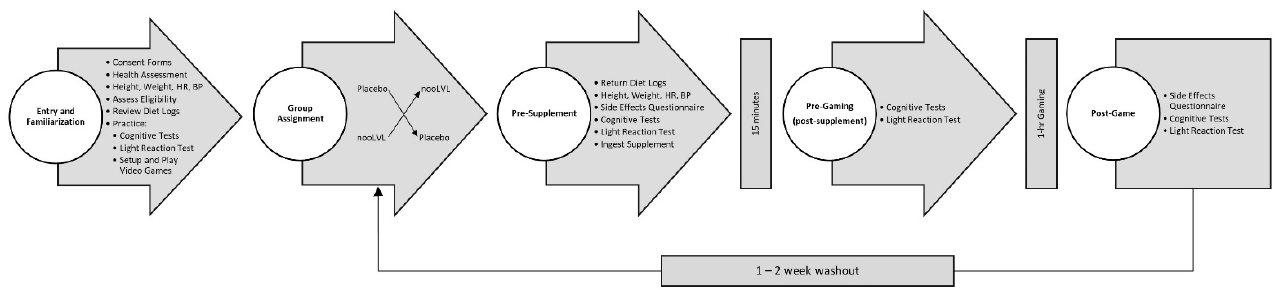
Figure 2. Overview of study protocol.